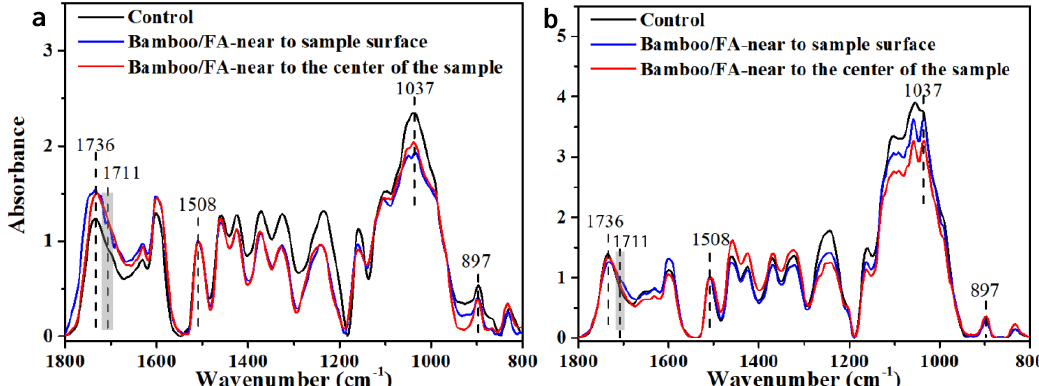
Figure 5. FT-IR spectra of the parenchymal cell walls ( a ) and fiber cell walls ( b ) of the control and surface furfurylated bamboo in the fingerprint region. Black line: FT-IR spectra of the control bamboo; blue-line: FT-IR spectra of the treated bamboo near the sample surface; red line: FT-IR spectra of the treated bamboo near the center of the samples.